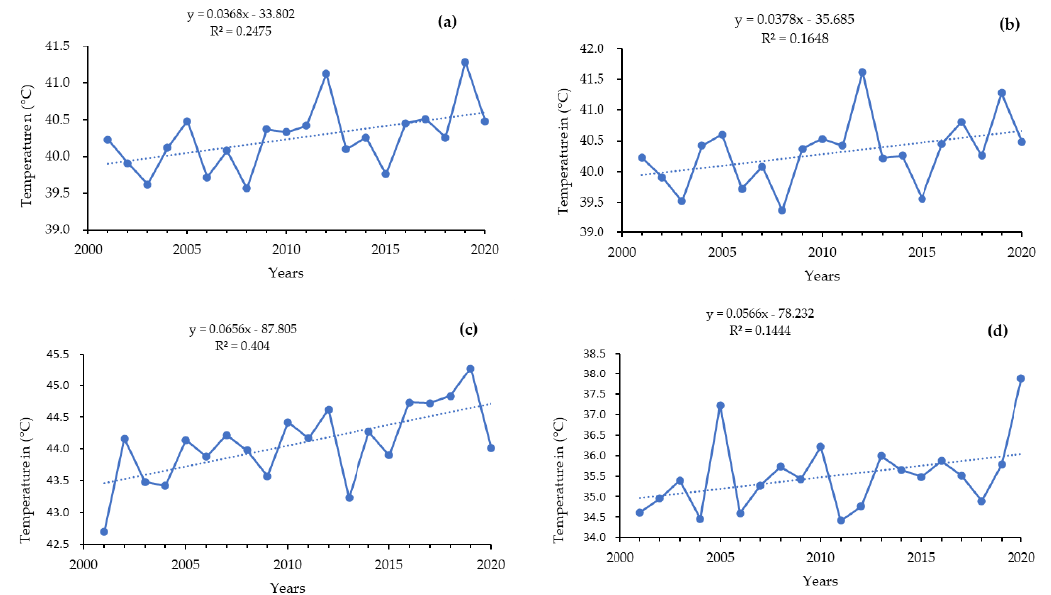
Figure A1. Variation trends in temperature from 2001–2020 at stations ( a ) TA 109, ( b ) TA 233, ( c ) J107, and ( d ) J108.